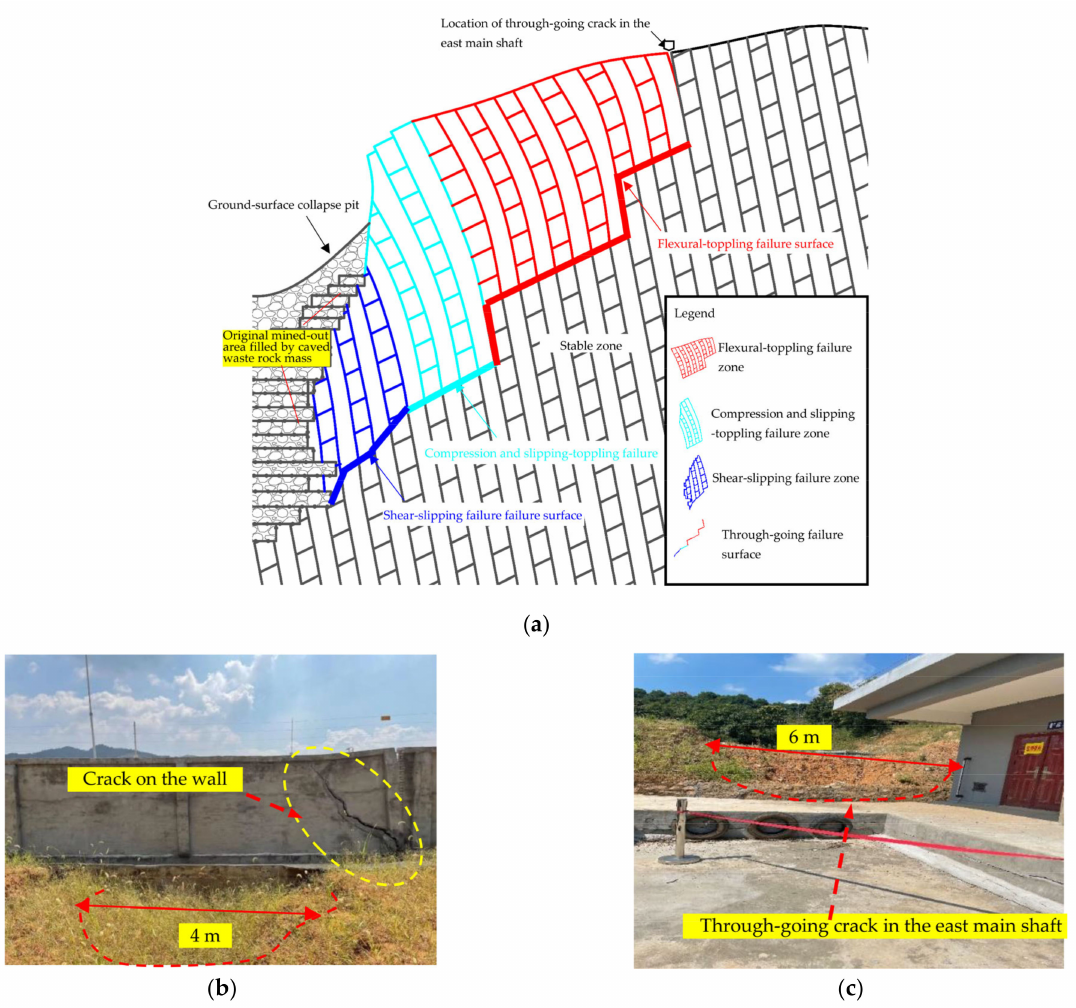
Figure 19. ( a ) Schematic diagram showing the different zones in the rock mass of the footwall. ( b ) Damaged buildings and facilities near the east main shaft. ( c ) The through-going crack in the east main